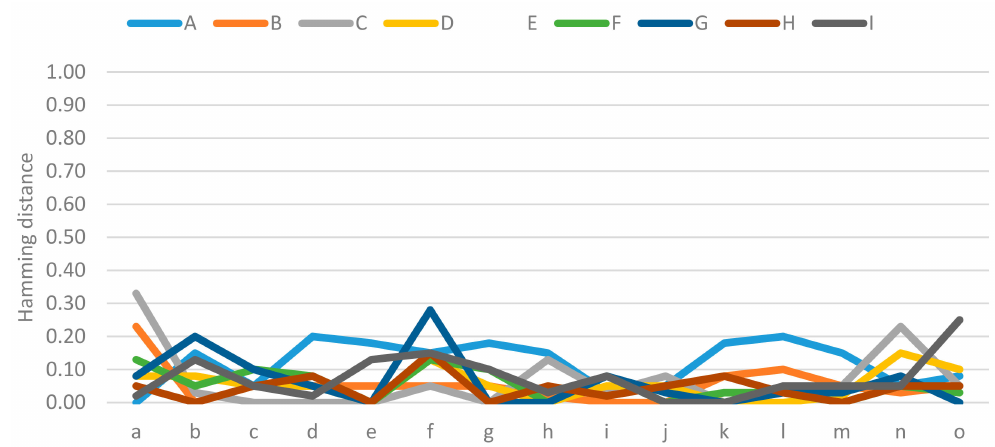
Figure 4. Hamming distance in the forgotten effects. Source: own